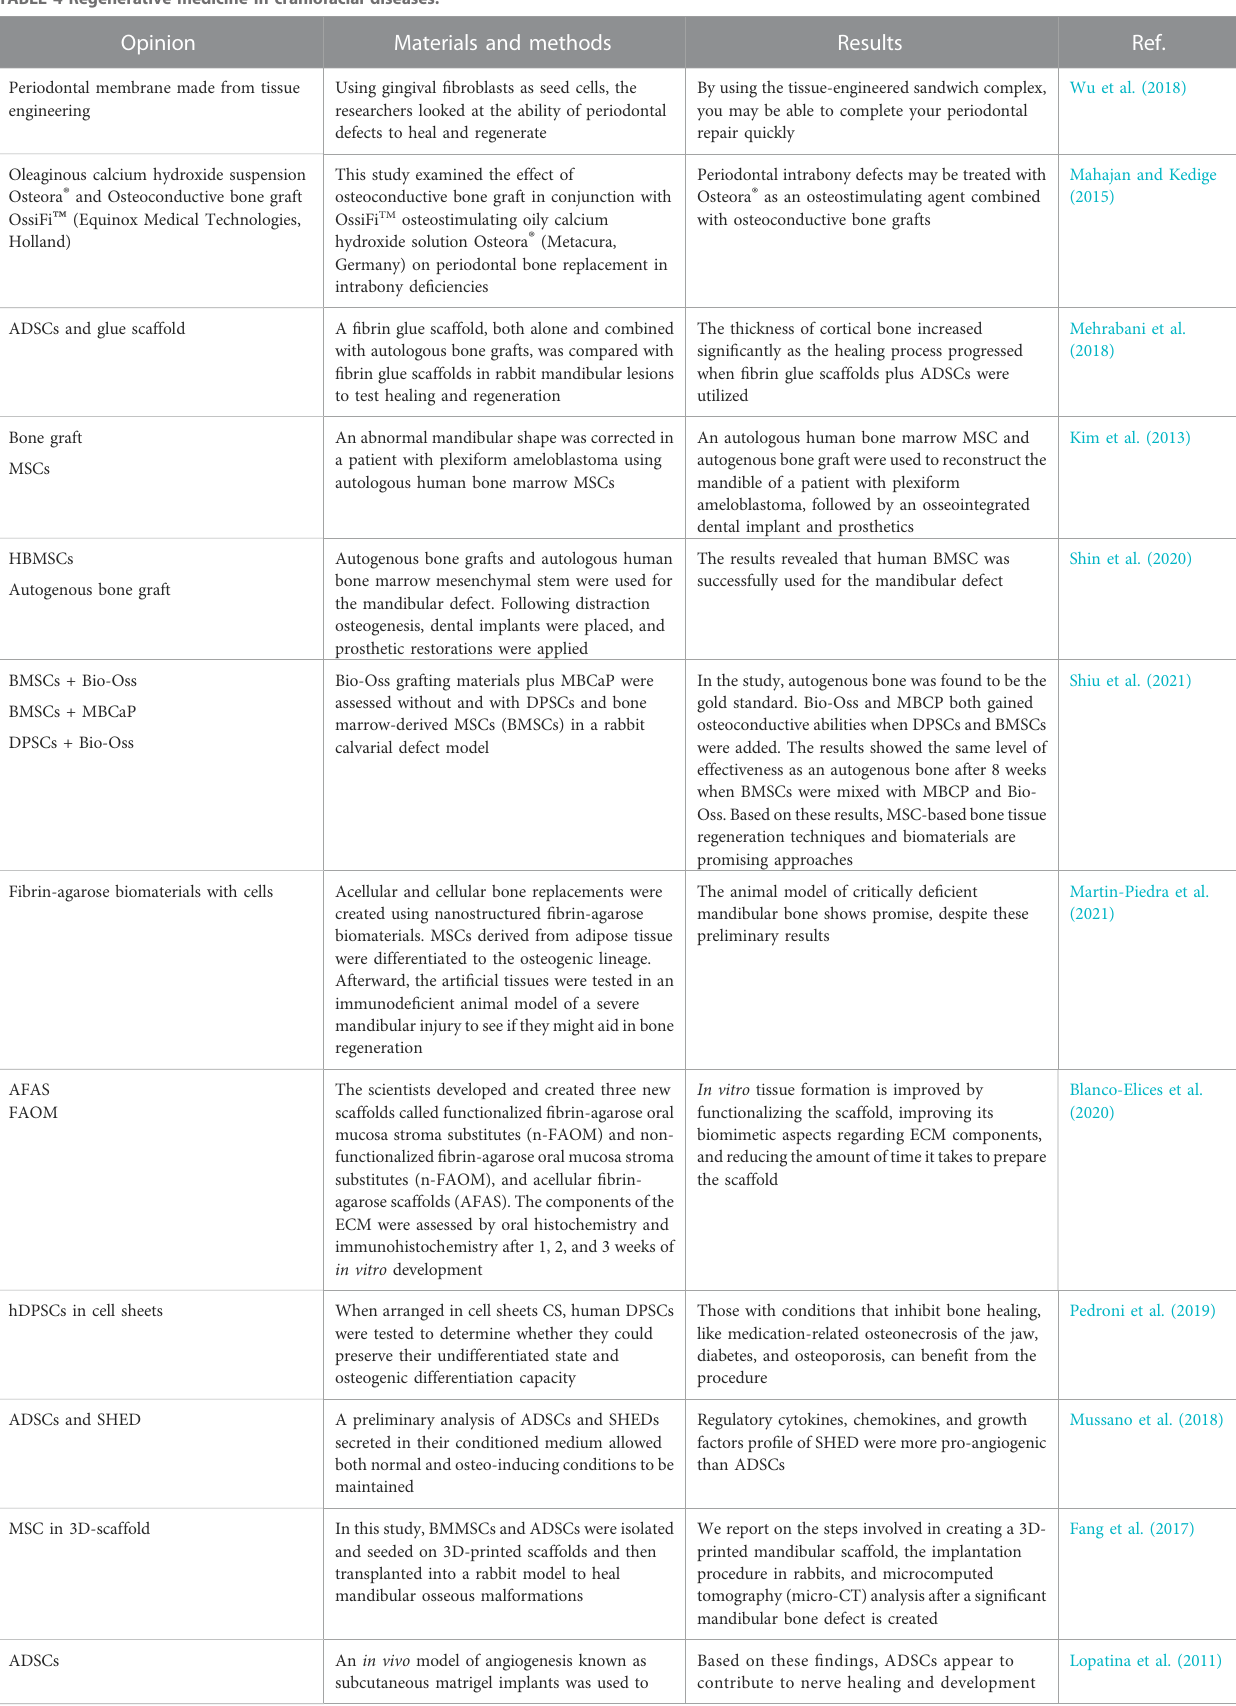
TABLE 4 Regenerative medicine in craniofacial